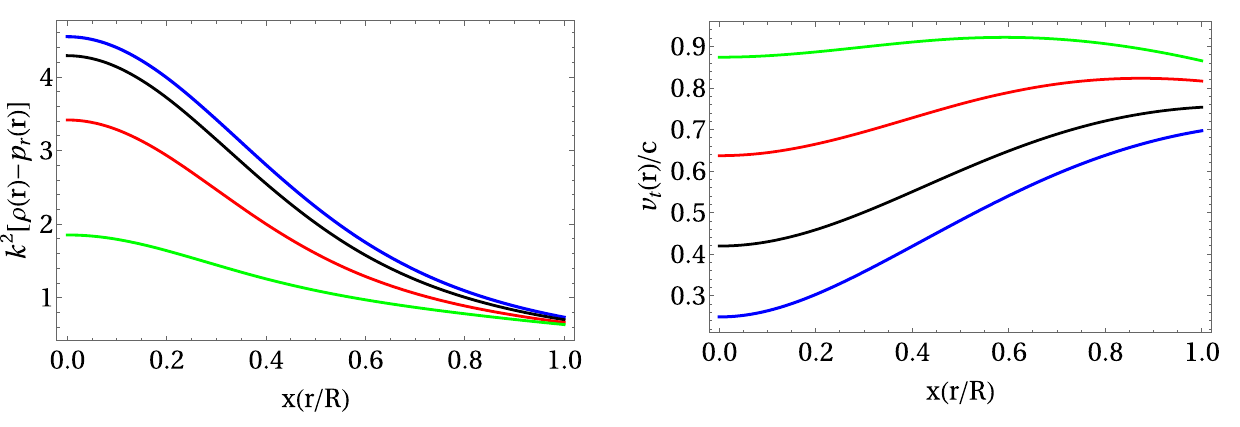
Fig. 17 v t ( r ) for Model II for compact factors: 0.38 (blue line), 0.39 (black line), 0.40 (red line) and 0.407 (green line)